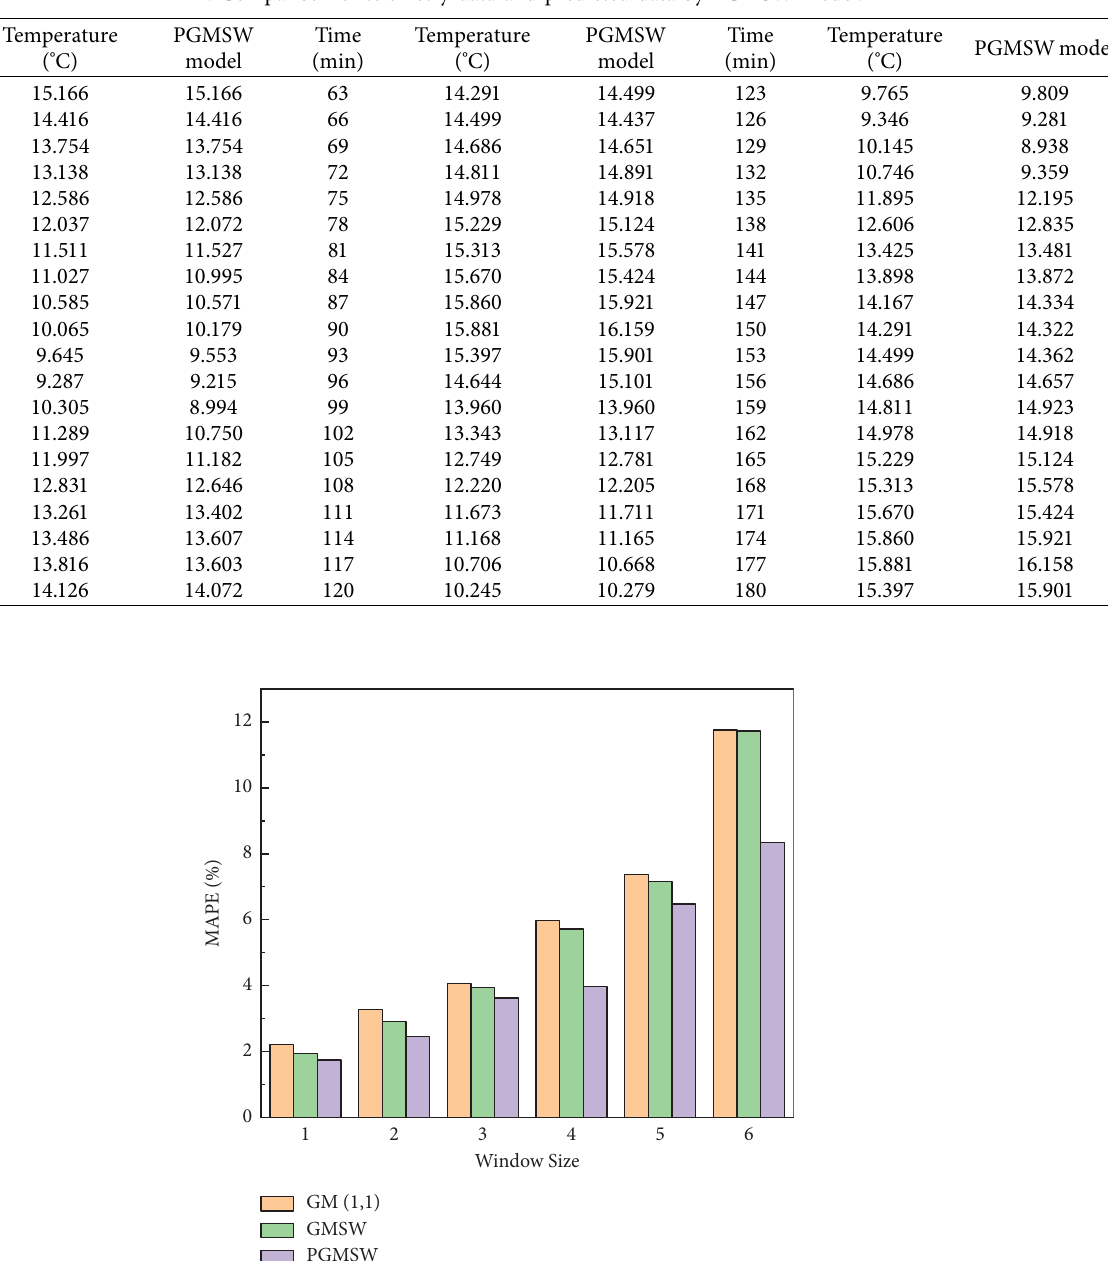
Table 2: Comparison of telemetry data and predicted data by PGMSW model.